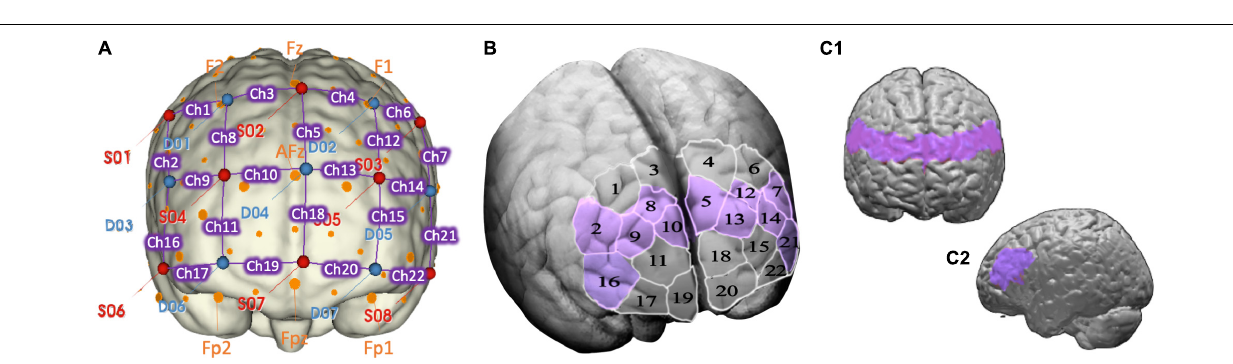
FIGURE 4 | fNIRS optode montage setup (topolayout) with marked regions representing Brodmann area 9 and 46. (A) fNIRS optode montage setup of the sources (S; red) and detectors (D; blue) with the associated fNIRS channels (Ch; purple) and the coordinates of the EEG 10-20 system (orange dots) (modified graphic from Nissen et al., 2019), (B) fNIRS channel areas plotted on a standardised brain with channels constituting Brodmann area 9 and 46 marked in purple (modified graphic from Krampe et al., 2018b), (C1) Brodmann area 9 and (C2) Brodmann area 46 marked in